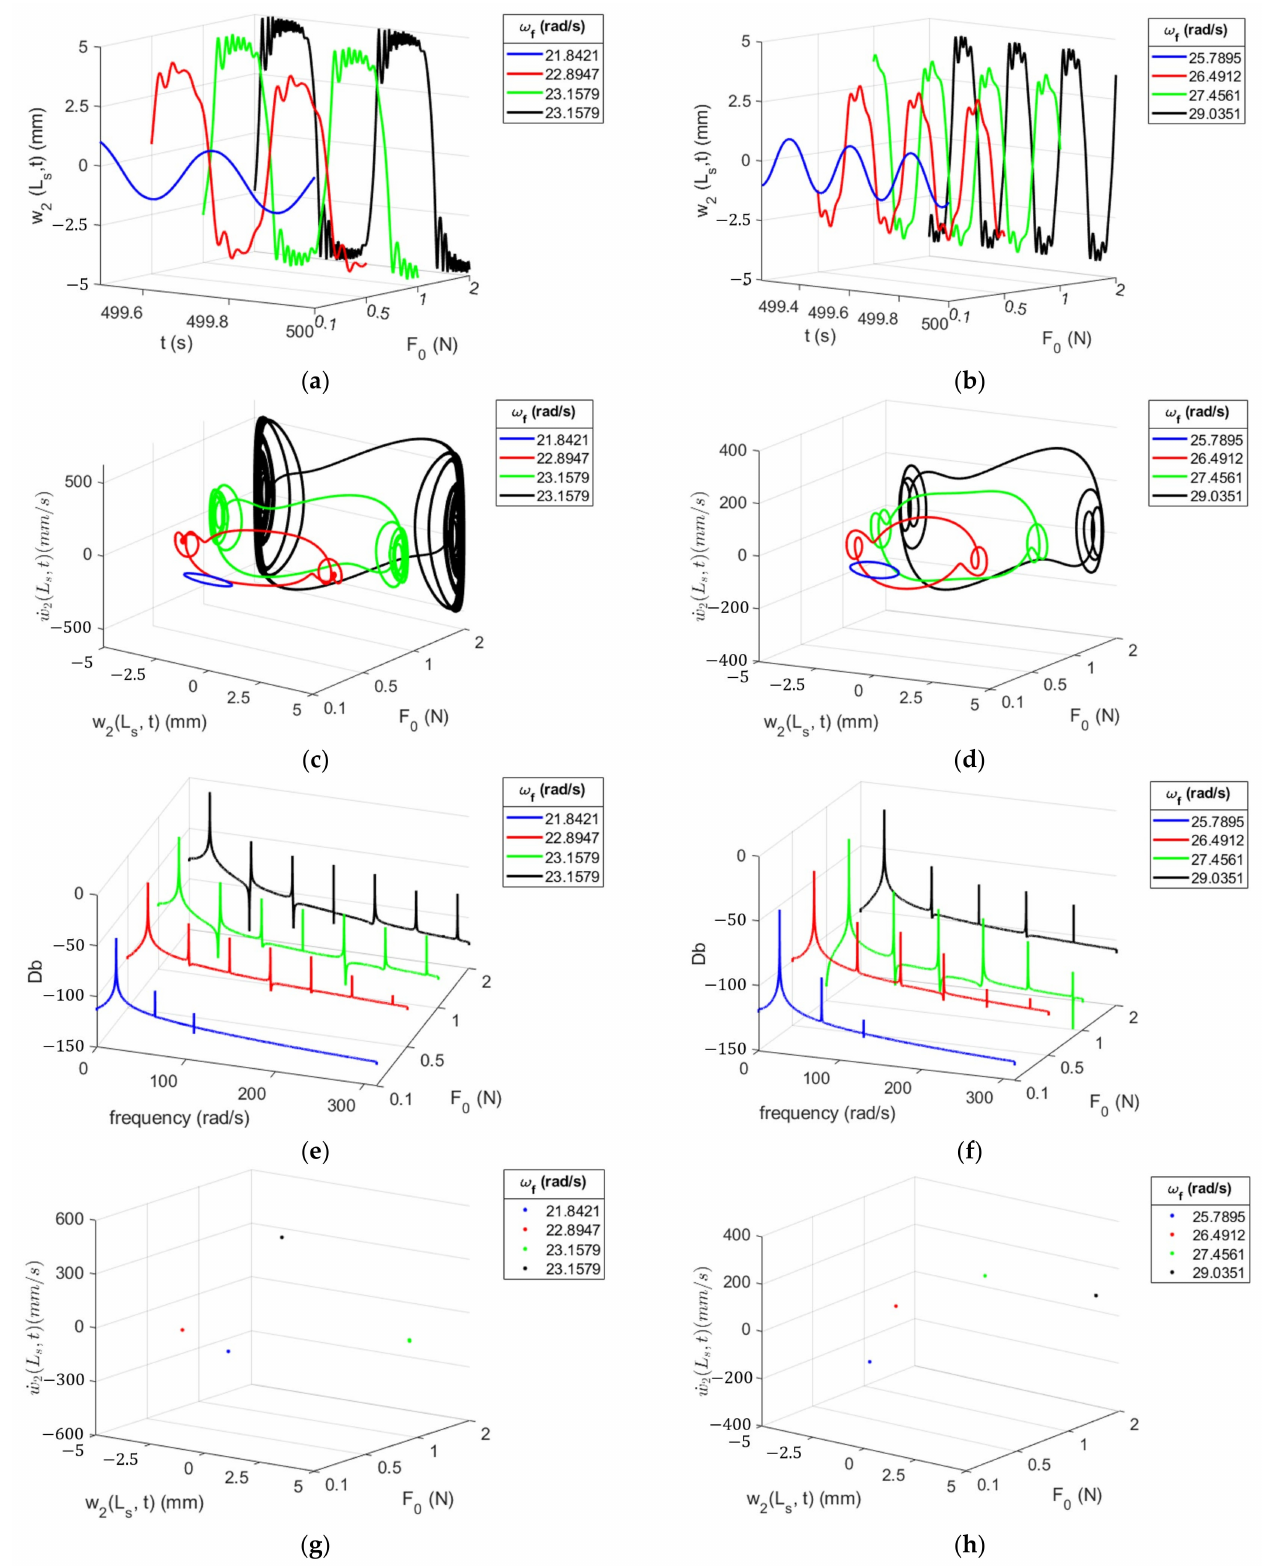
Figure 36. Nonlinear characterization of the absorber’s first (first column) and second peaks (sec- ond column) utilizing time histories ( a , b ), phase portraits ( c , d ), power spectra ( e , f ) and Poincare maps ( g , h